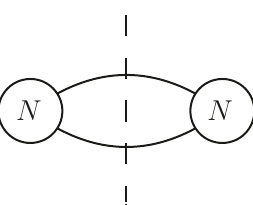
Figure 9 : The quiver diagram for the M = 2 theory; the dashed line represents the mirror effect of the orientifold